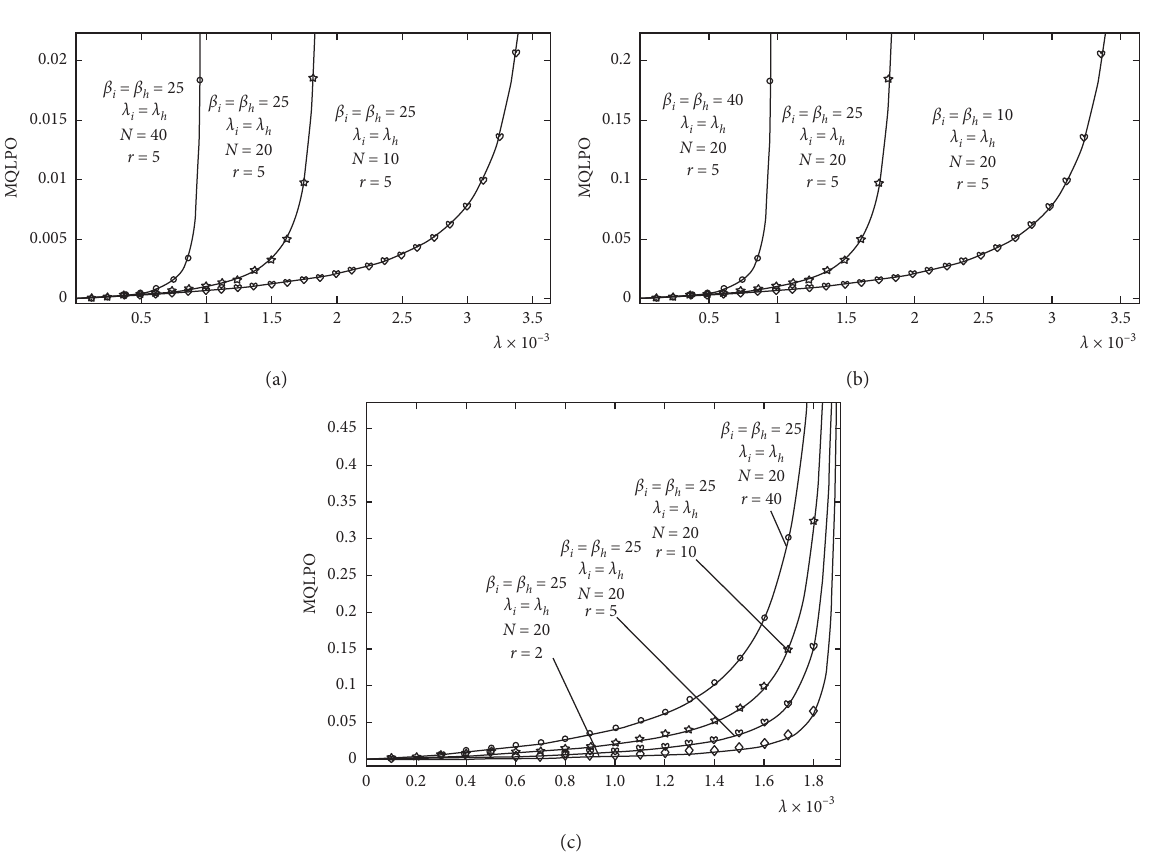
Figure 2: The change trend of MQLPO. (a) Range of MQLPO with λ ′ s change under different N . (b) Range of MQLPO with λ ′ s change under different β. (c) Range of MQLPO with λ ′ s change under different r